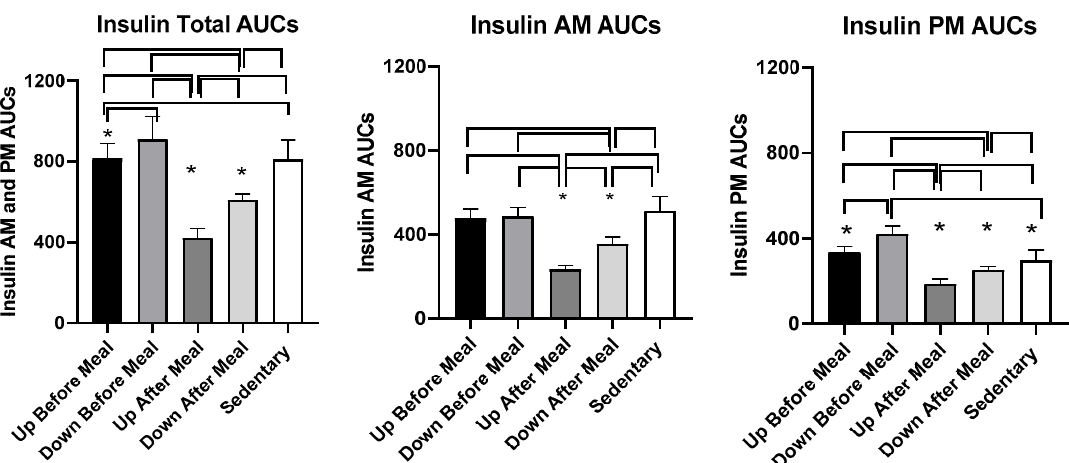
Figure 9. Postprandial insulin AUCs after the morning and afternoon meals combined (left) and after the morning (center) and afternoon (right) meals individually. Greatest decreases in insulin AUCs were in the exercise-after-meal trials (UAM) relative to sedentary trials and relative to exercise-before-meals trials in combined (left) as well as individual AUCs (center and right). In addition, within the exercise-after-meal condition, afternoon UAM AUC was lower than the DAM AUC. * indicates significant difference relative to groups marked by the overhead bracket